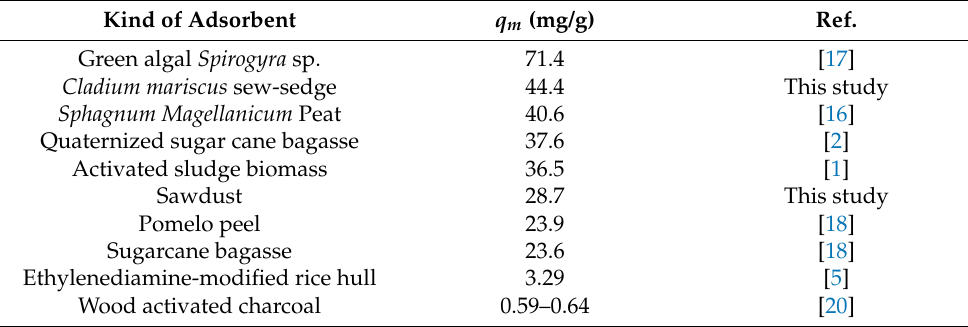
Table 5. Comparison of adsorption capacity of low-cost adsorbents towards BB3. Kind of Adsorbent q m (mg/g)